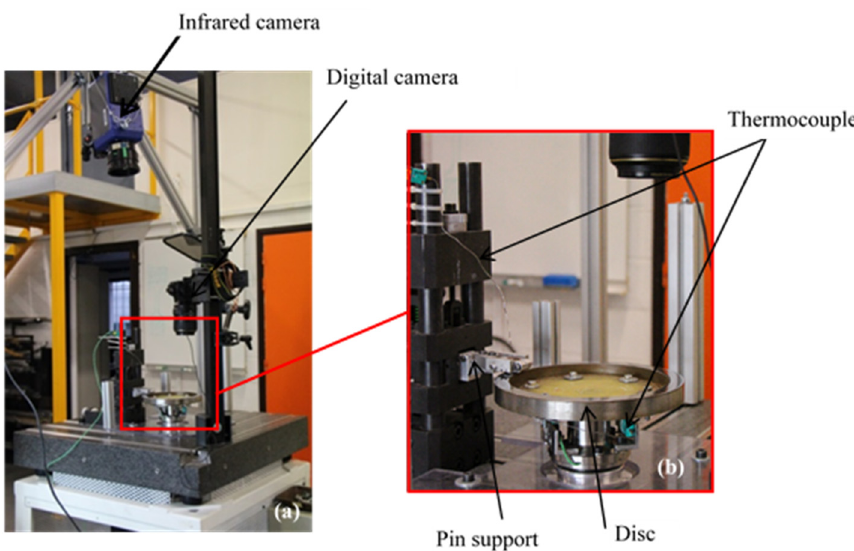
Figure 3. ( a ) Experimental set-up and ( b ) Pin-on-disc